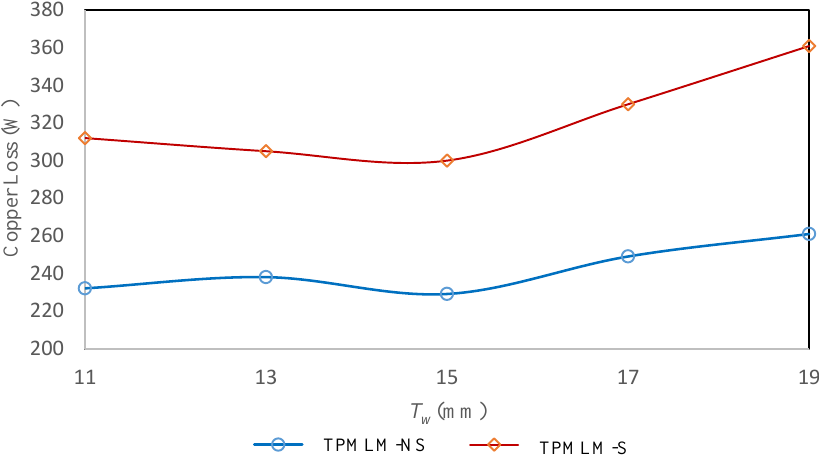
Figure 22. Influences of T w Variation on Copper Loss.